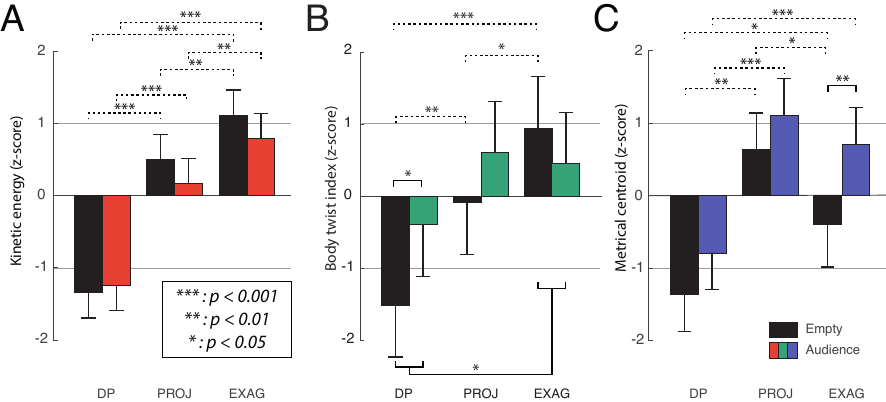
Figure 2. Impact of the interaction of the expressiveness and the presence of an audience on body features (deadpan: DP, projected: PROJ, and exaggerated: EXAG): ( A ) Kinetic energy (red); ( B ) Body Twist Index (green); and ( C ) Metrical centroid (blue). (* p < 0.05, ** p < 0.01, *** p <